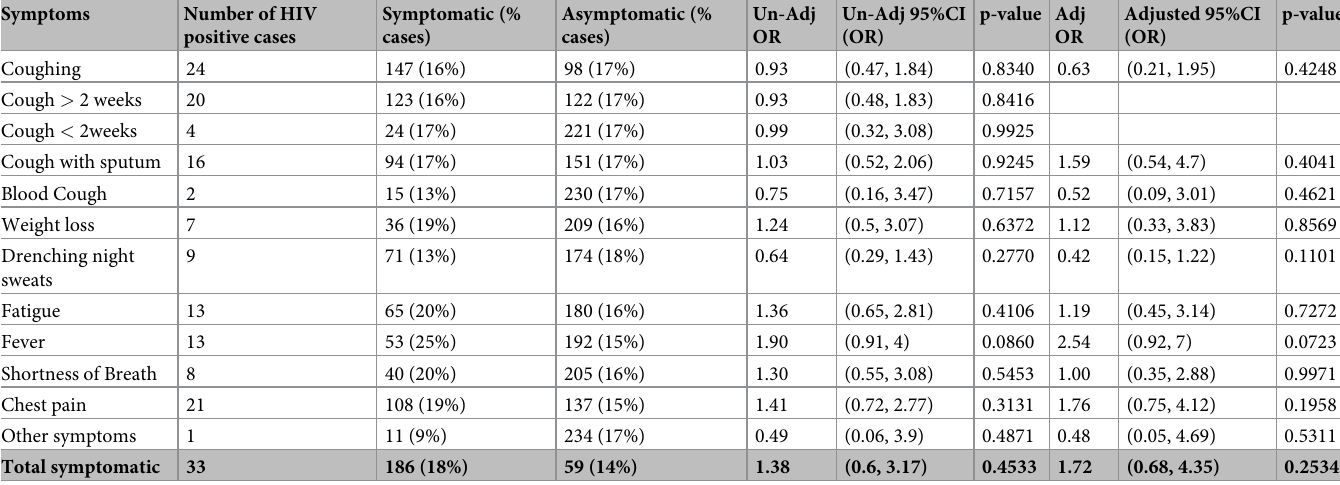
Table 10. Association between TB related symptoms and HIV status among the 245 survey cases with known HIV status. Symptoms Number of HIV positive